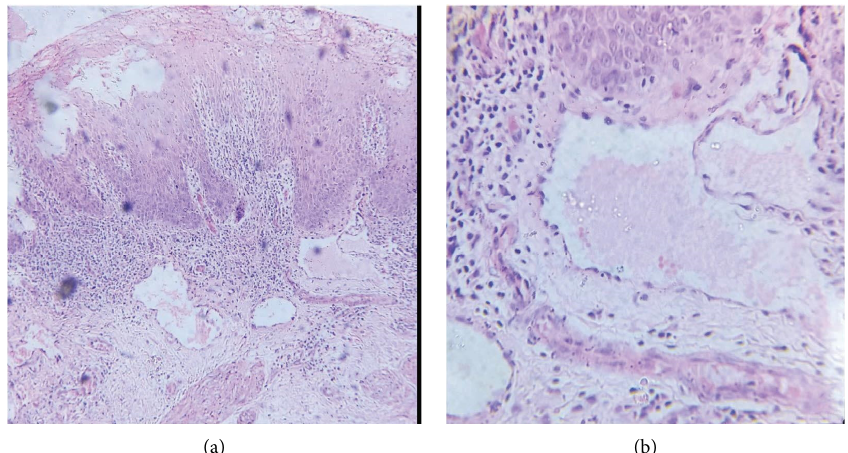
Figure 3: (a) Histopathological examination showing multiple dilated vessels on the upper dermis (H&E 10x). (b) Single layer of cells in the vessel wall and eosinophilic material in lumen (H&E 40x).